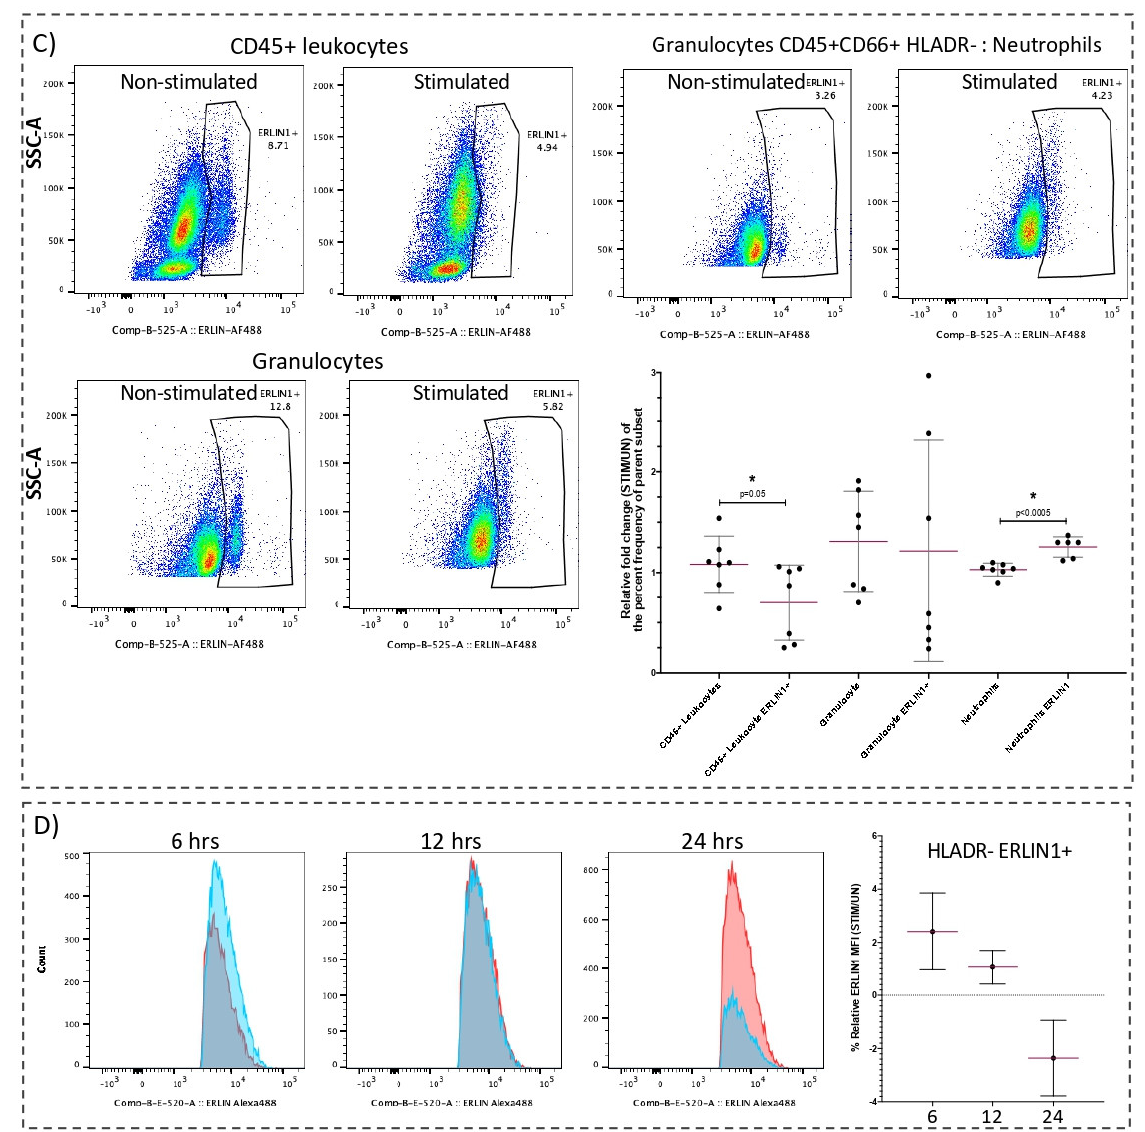
Figure 1. Abundance of ERLIN1 transcript and proteins in cultured whole blood and HL60 cells in response to LPS/PGN exposure. ( A ) Experimental designs for in vitro stimulation of cultured whole blood and HL60 cells. Whole blood was incubated with or without (UN) a combination of lipopolysaccharide (LPS, 100 ng/mL) and peptidoglycan (PGN, 5 ug/mL) for 6 h with stimulation prior to total RNA extraction and RT-qPCR quantification. Determination of protein levels by flow cytometry and cholesterol assays was performed after 24-h stimulation. For HL60, cells seeded at 3E06 cells/mL were differentiated for six days prior to stimulation for 6, 12, and 24 h with LPS/PGN, followed by processing for flow cytometry and cholesterol assays as described in the Materials and Methods section. ( B ) Whole blood from healthy donors ( n = 8) after 6 h with LPS/PGN or culture medium (control). ERLIN1 expression was assessed by RT-qPCR and normalized to GAPDH transcript expression. ( C ) Representative dot plots of ERLIN1 abundance in cultured whole blood immune cells before and after stimulation for 24 h (expressed as % of parent cell population). After culture, cells were harvested in BD FACS Lyse and stored at − 80 ◦ C until staining. Immunostaining and flow cytometry were performed as described in the Materials and Methods section. Gates were calibrated using all-minus-one staining mix (Figure S4). The summary of the main findings shows the relative fold change (STIM/UN) of the percentage frequency of the parent subset. ( D ) Relative abundance of ERLIN1 in HL60 cells at 6, 12, and 24 h, expressed as the fold change in median fluorescence intensity (MFI) for each stimulation time (stimulated/non-stimulated); blue and red histograms represent stimulated and non-stimulated, respectively. * p -value ≤ 0.05. **** p -value <